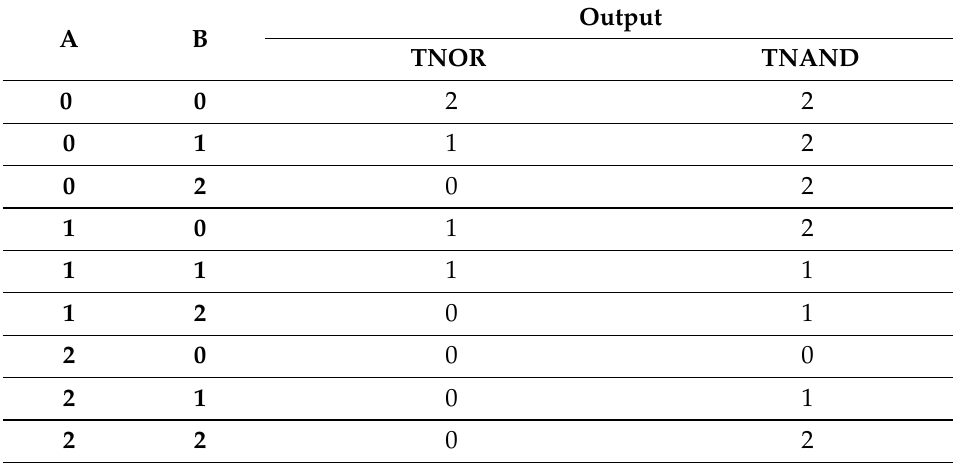
Table 2. Ternary logic gates TNOR and TNAND truth table.